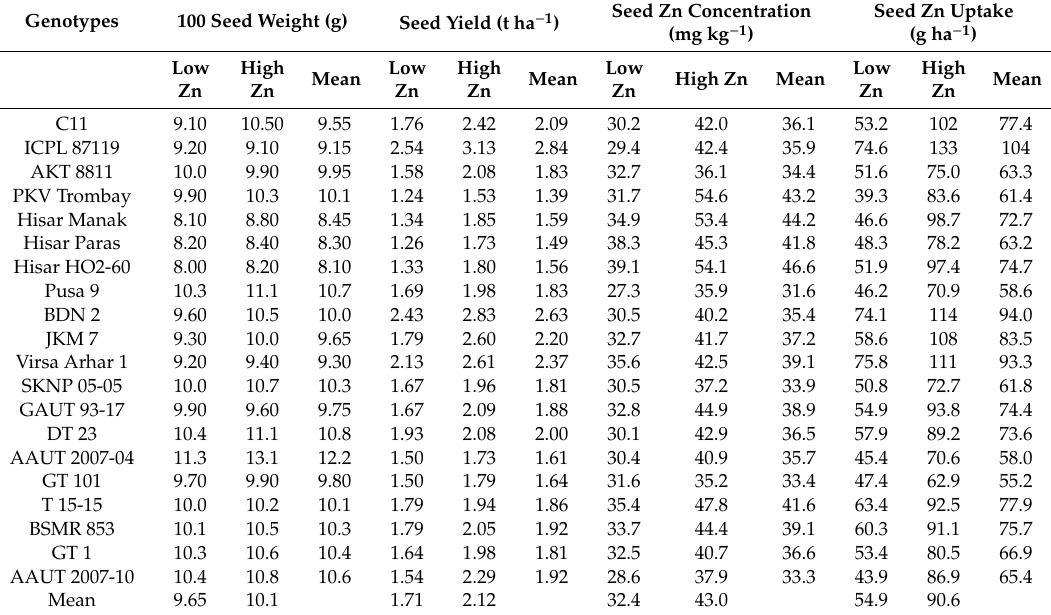
Figure 1. Radar diagrams showing mean ( a ) plant height (m), ( b ) branches plant − 1 , ( c ) pods plant − 1 , and ( d ) seed pod − 1 of pigeonpea genotypes grown under low and high zinc (Zn) treatments. Table 3. Hundred seed weight (g), seed yield (t ha − 1 ), seed zinc (Zn) concentration (mg kg − 1 ), and seed Zn uptake (g ha − 1 ) of pigeon pea genotypes under low and high Zn treatments. SED = standard error of difference, LSD = least significant difference. NS = not significant at p < 0.05, * denotes significant at p < 0.05.